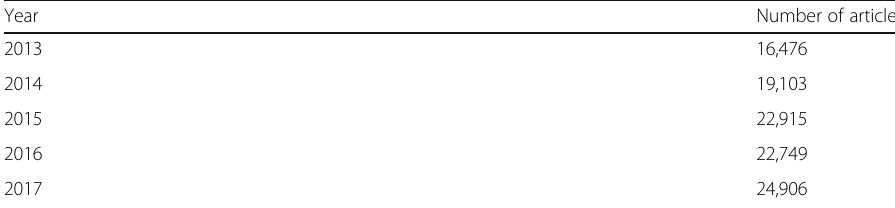
Table 1 ScienceDirect Search